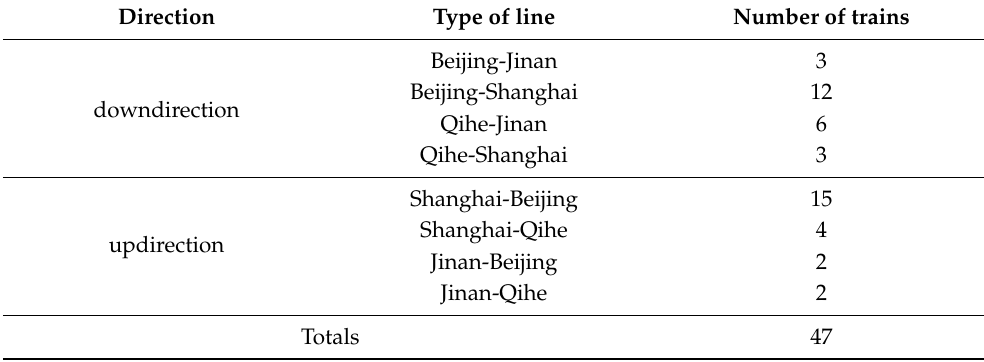
Table 5. Result of scenario